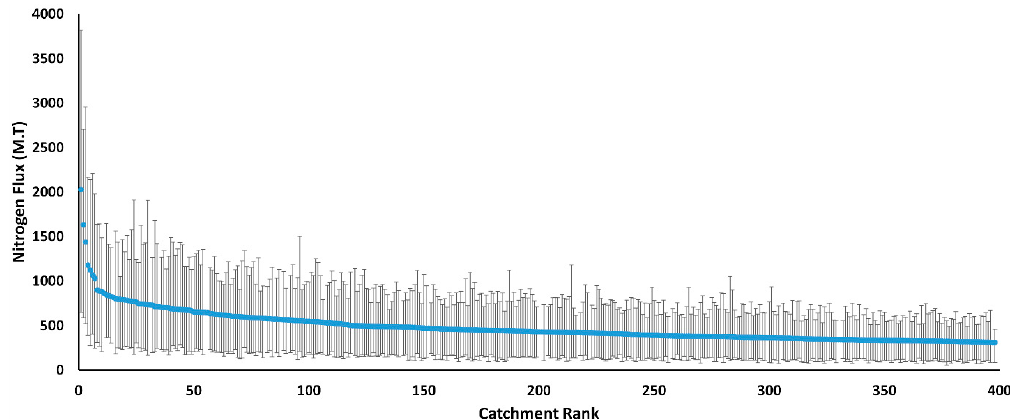
Figure 8. Nitrogen flux as a function of catchment rank.